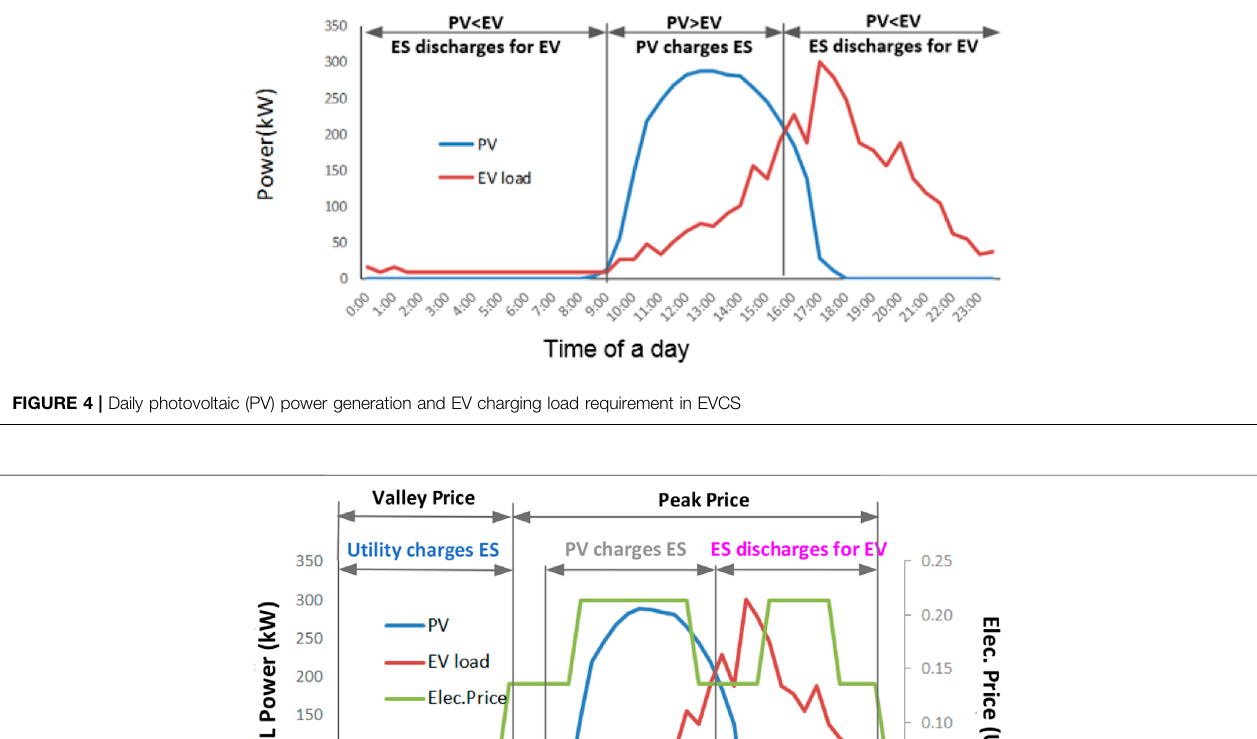
Frontiers in Energy Research |